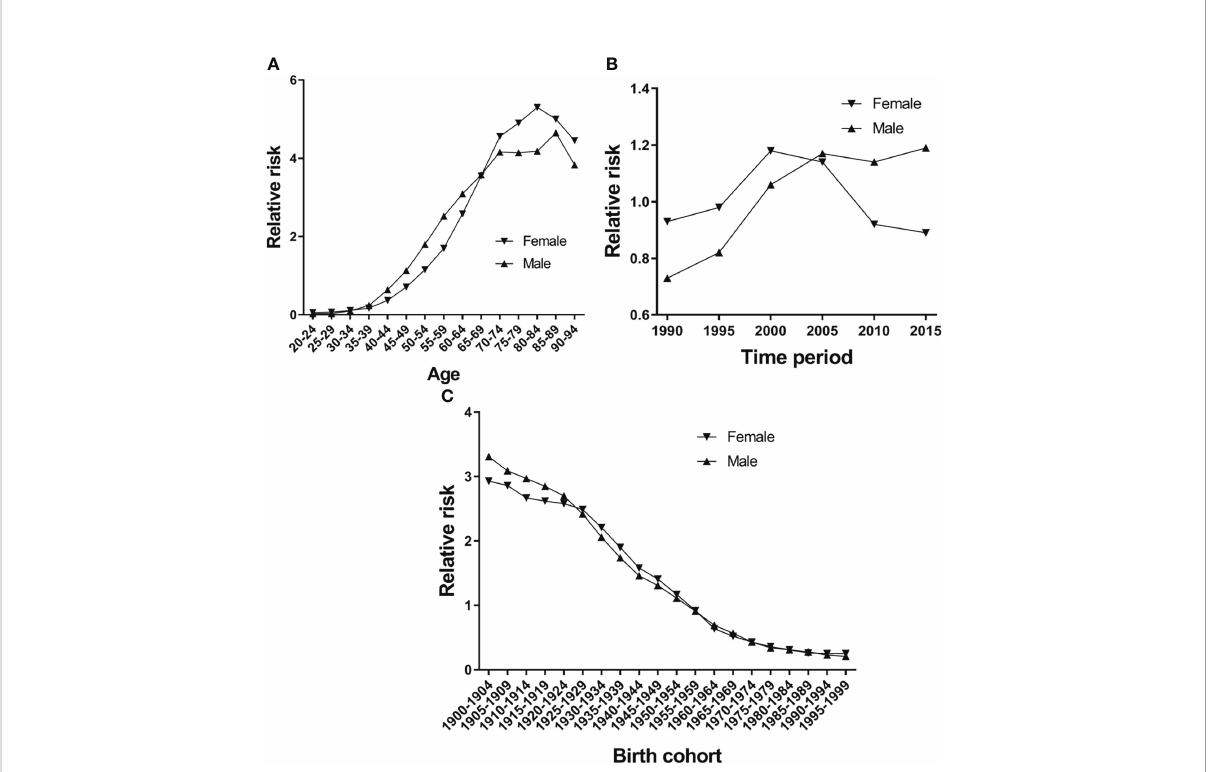
FIGURE 5 Esophageal cancer incidence relative risk due to (A) age; (B) period; and (C) cohort by using age-period-cohort model analysis with the intrinsic estimator